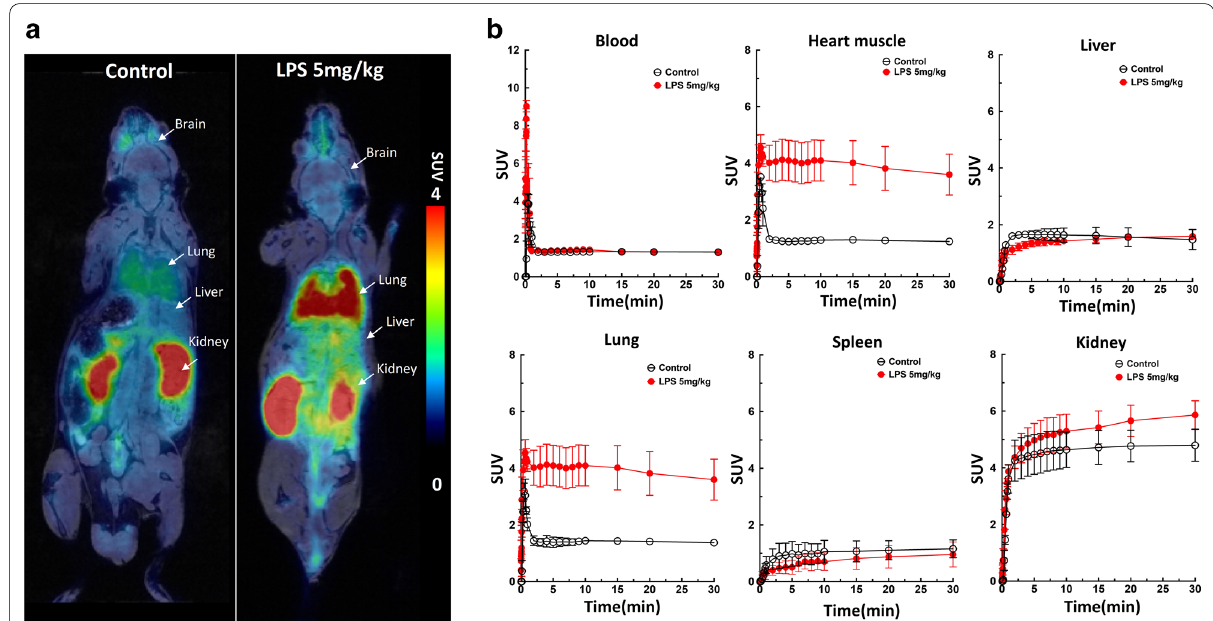
Fig. 2 a Representative whole‑body coronal PET/MR images of [ 18 F]FEPPA in control and 24h LPS‑injected animals (5 mg/kg, i.p.). PET images were generated by summation of the whole scan (0–30 min) and color‑coded to the range of SUV values. b Time activity curves for [ 18 F]FEPPA radioactivity (SUV) in blood, heart muscle, liver, lung, spleen and kidney. Data are mean